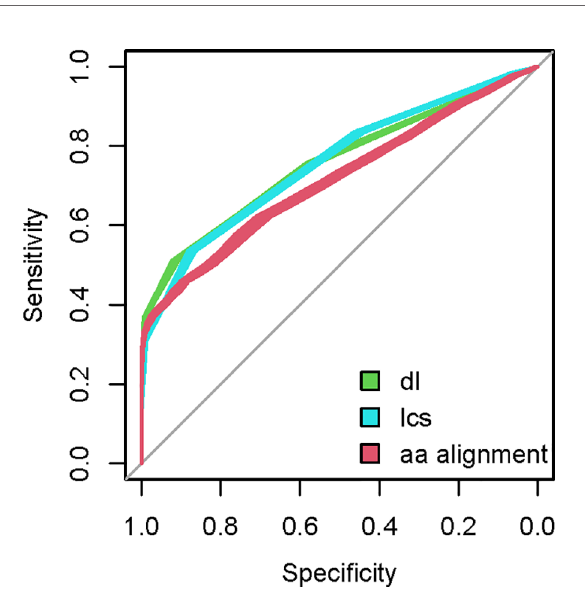
FIGURE 2 | Examples of ROC curve sets for three string metrics - Demerau- Levenstein (dl), longest common subsequence distance (lcs) and pairwise alignment based on the BLOSUM62 scoring matrix. Twenty ROC curves are constructed with each metric using 20 random samples of G library sequences to pair with the mimotopes of known mAb from the Biopanning Data Bank and compared to isospeci fi c pairs from the data bank.